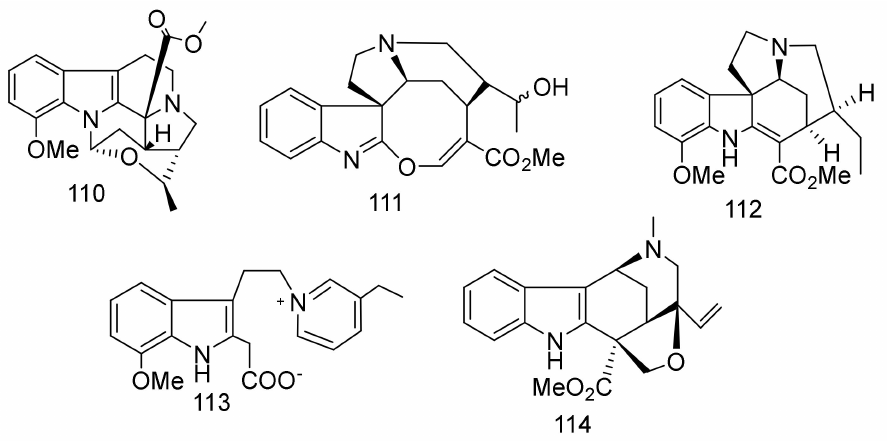
Figure 14. Compounds 110 – 114